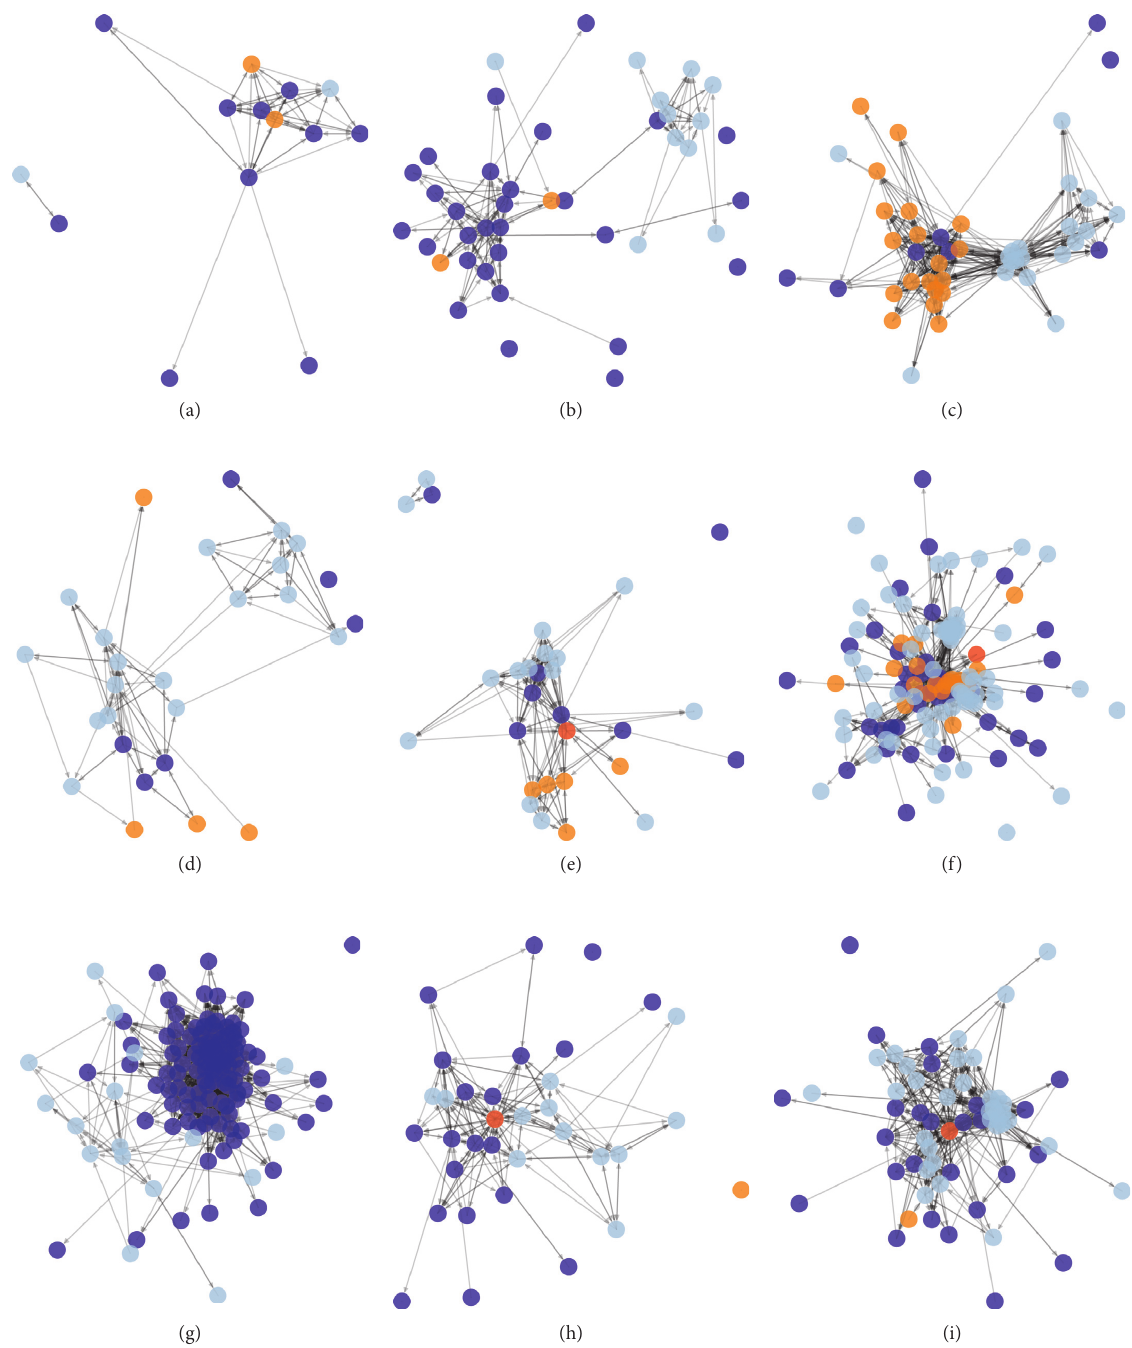
Figure 5: Visualization of social communication networks from select enterprises. Distinct networks represent different enterprises. Nodes are user colored by their role (red is for an executive, dark blue is for a manager, orange is for a supervisor, and light blue is for an operator). Edges are directed and represent messages in online chats. Other enterprises are shown in Section